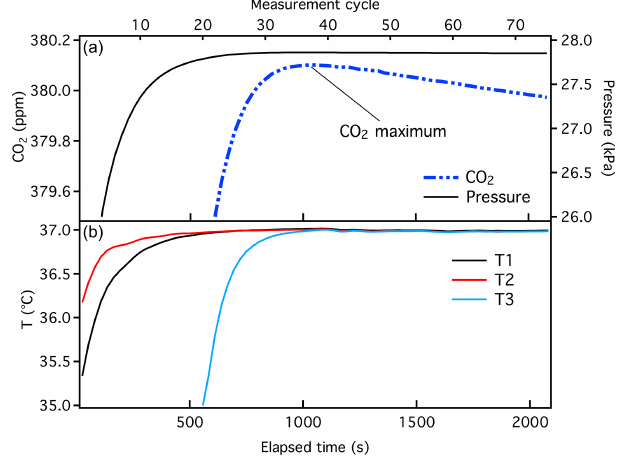
Figure 2. Typical data from a manometric run, showing the small volume pressure and CO 2 ( + N 2 O) calculated as a function of time (a) , and temperature measured at three locations within the oven (b) . Historical manometric records are time-stamped with “measurement cycle”, which is shown on the upper x axis. Here, each measurement cycle corresponds to ∼ 30s. Temperature probe T3 is adjacent to the small volume and is cooled to liquid nitrogen temperature during extraction.